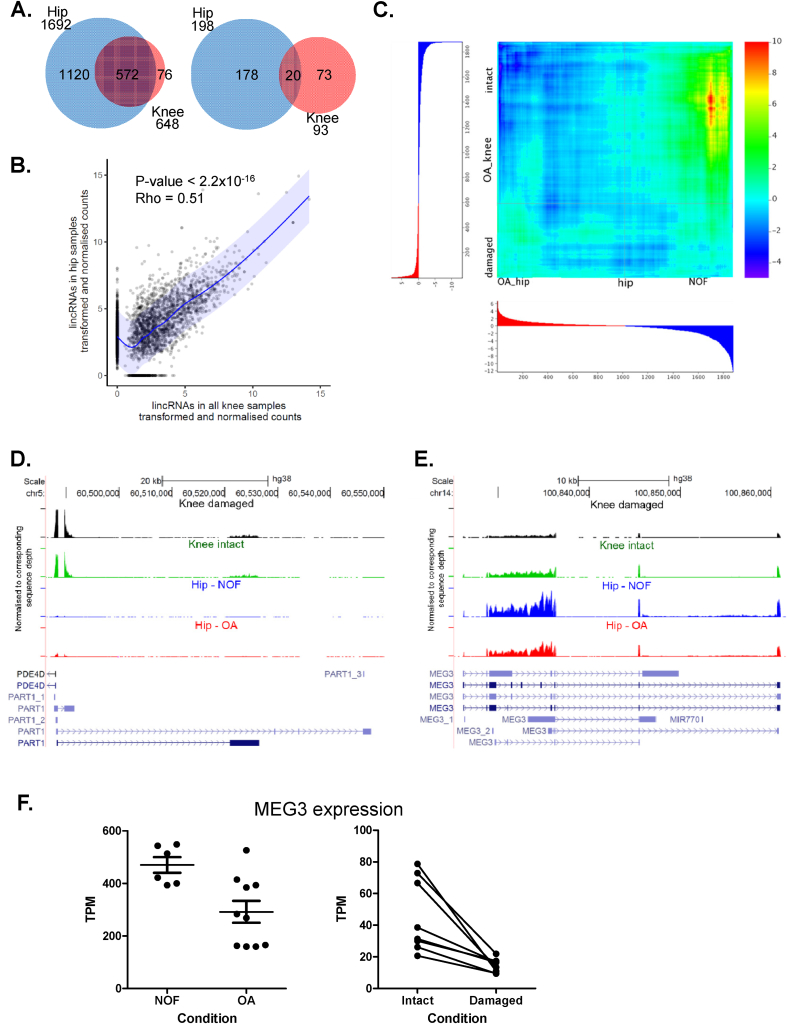
Joint site comparisons in lincRNA expression. A. Venn diagrams showing the 572 lincRNAs in common between hip and knee and those differentially expressed between the tissues and disease status at both joint sites (20). B. Scatter plot of mean lincRNA counts (TPM) for all hip samples (NOF and OA hip) vs all knee (intact and damaged) samples. C. Rank–rank hypergeometric overlap representation of lincRNA lists ranked by the degree of differential expression observed in the two profiling experiments (positive values indicate an enrichment of overlapping lincRNAs). Key depicts –log10 P value. Axis graphs depict ranked gene regulation with red and blue highlighting upregulated and downregulated lincRNAs, respectively, in damaged knee or OA hip datasets. D. Total read coverages of each sample group on UCSC Browser hg38. PART1 expression in damaged & intact knee OA, and hip OA & NOF. E. Read coverage plot on UCSC Browser hg38. MEG3 expression in damaged & intact knee OA, and hip OA & NOF. F. MEG3 expression in individual NOF vs hip OA and intact vs damaged paired knee OA samples. TPM for each experimental dataset are presented.